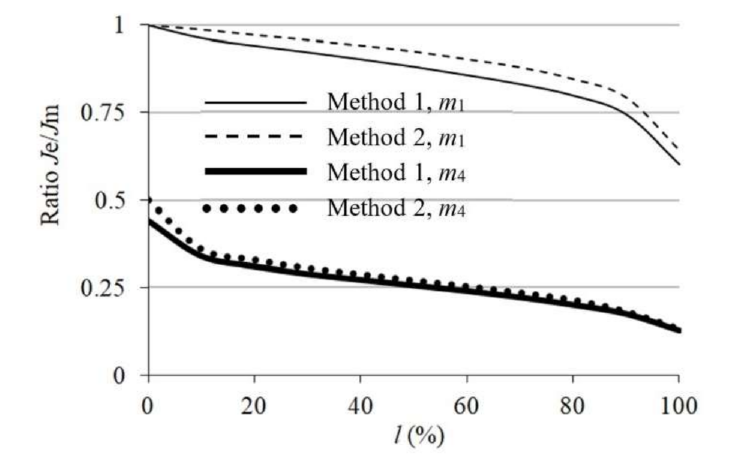
Figure 11. Ratio Je/Jm in the state-estimation process for load level V 0.5